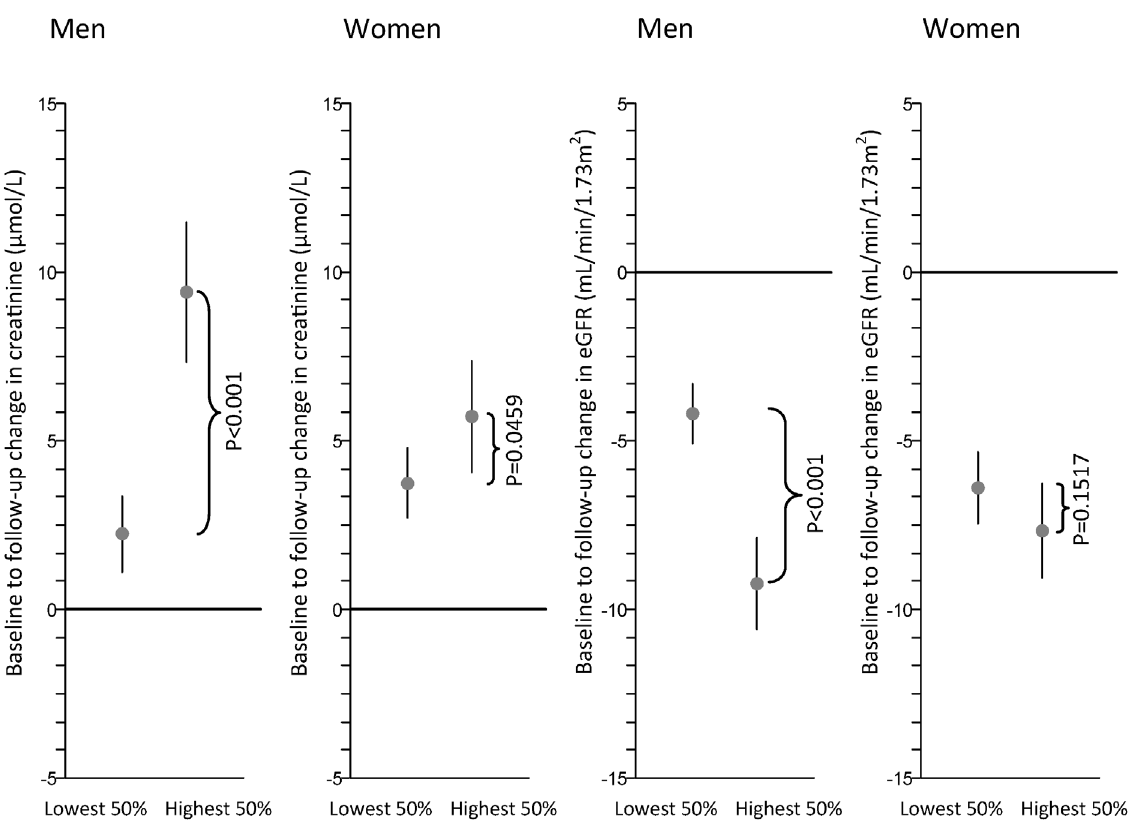
Figure 2. Change in mean eGFR/creatinine plasma level in subjects with the 50% lowest and 50% highest sTNF-R1 plasma levels at baseline. Abbreviations: sTNF-R1: Soluble tumour necrosis factor- a receptor 1, eGFR: estimated glomerular filtration rate.